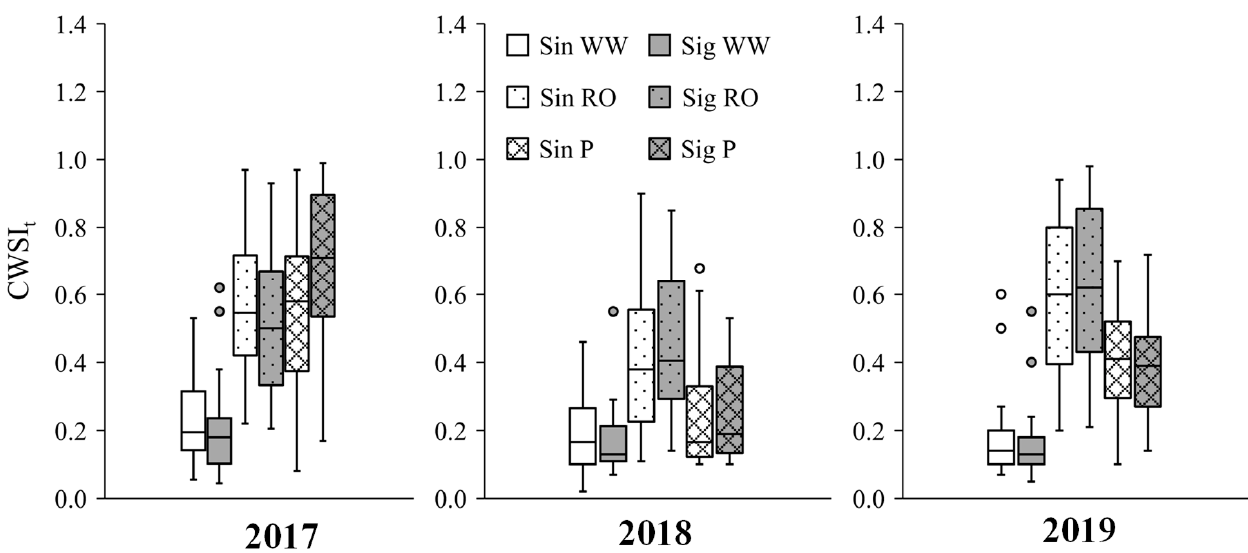
Figure 4. Seasonal mean of theoretical crop water stress index, CWSI t for soybean varieties Sinara (Sin) and Sigalia (Sig) during the seasons between 2017 and 2019. WW, RO and P denoted unlimited, water stress and rainfed, respectively.